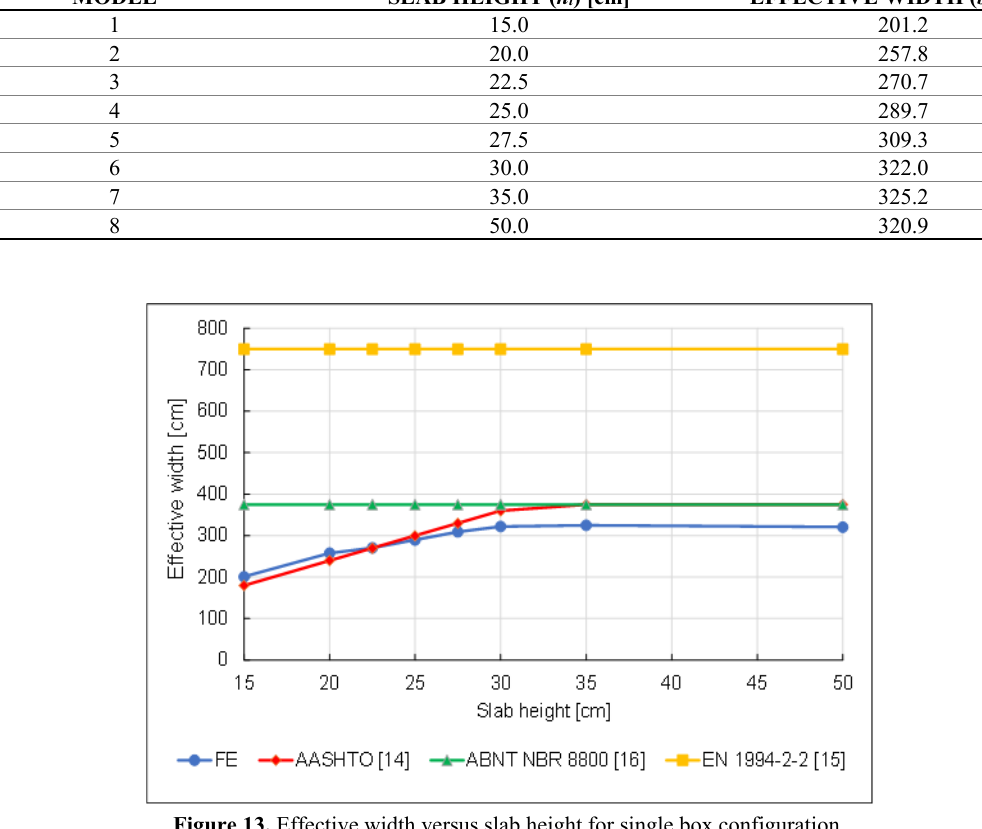
Table 3. Numeric effective width versus slab height for single box con figuration. MODEL